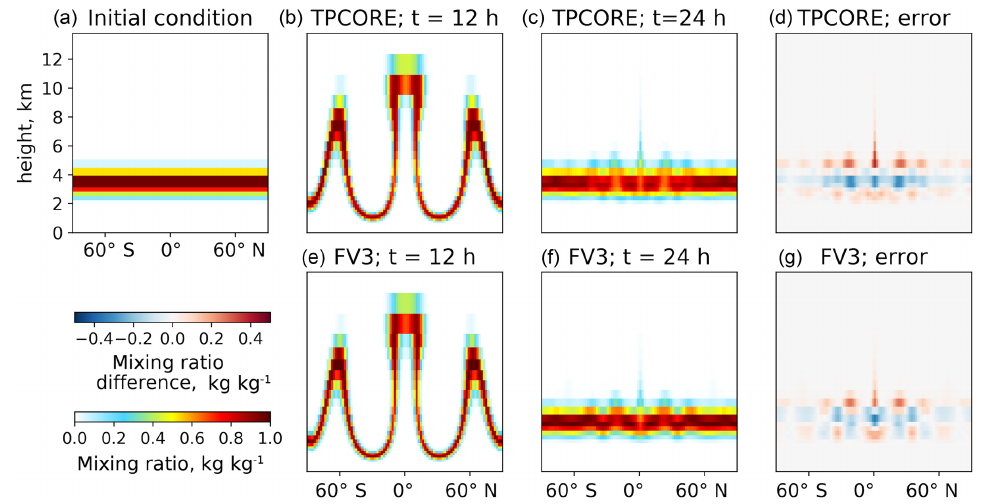
Figure B1. Comparing vertical diffusion in the GEOS-Chem CTM using either the TPCORE Eulerian advection scheme (b–d) or the FV3 vertically Lagrangian advection scheme (e–g) . A Hadley-like circulation test is applied to both schemes with rising motion in the first 12h followed by return to the original state in the next 12h (Kent et al., 2014). The tracer field is independent of longitude. The true solution at the final state ( t = 24h) should be the same as the initial condition (a) , and the deviation from the initial condition is due to numerical error. The error (d, g) is defined as final state minus initial